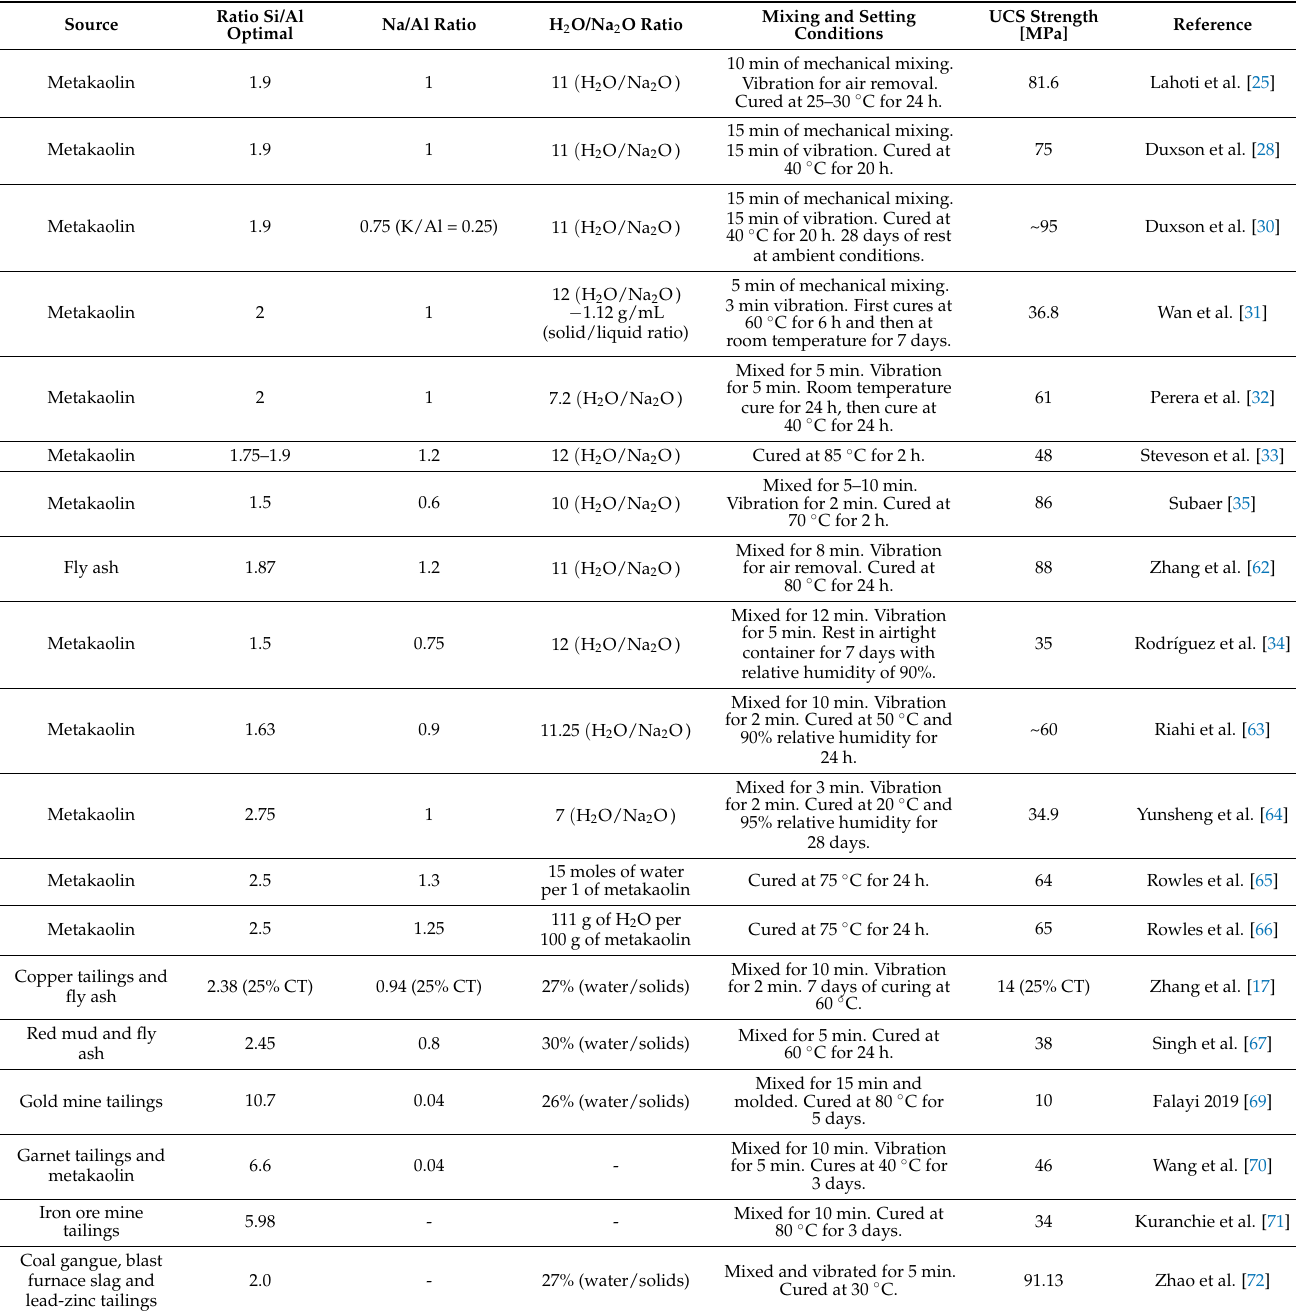
Table 3. Summary of bibliographic research on the influence of ratios on mechanical strength (CT = Copper tailings).